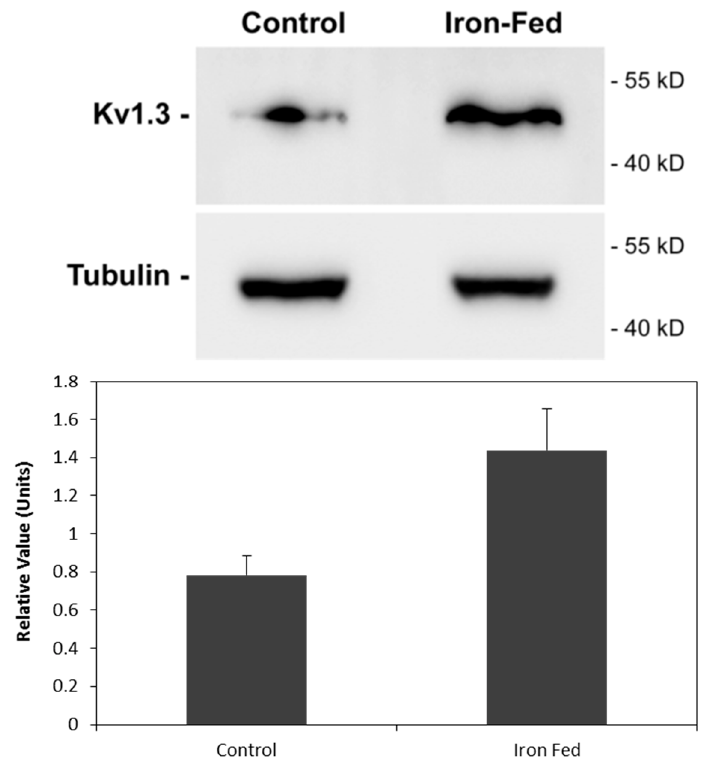
Figure 4. Expression of the potassium channel Kv1.3. Protein extracts were prepared from control and iron-fed C8B4 microglia. Western blot analysis was carried out to determine the level of Kv1.3 in the microglia. Bands for the protein were observed in both control and iron-fed microglia. Levels of tubulin were also determined to verify protein loading. The results showed a significant ( p < 0.05) elevation of Kv1.3 in iron-fed microglia. Shown are the mean and S.E.M. of four separate experiments.